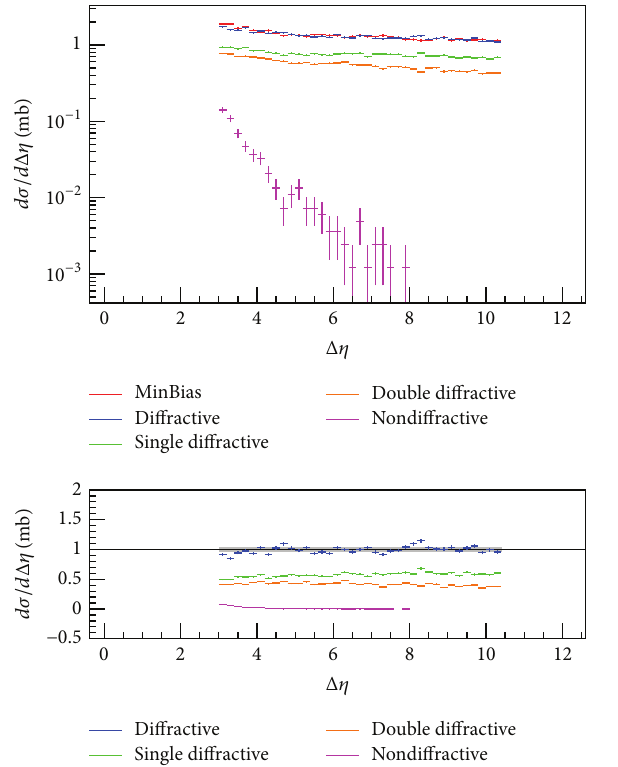
Figure 9: Large rapidity gap distribution for the events that have a central gap Δ𝜂 > 4 with a cut of 𝑝 T > 200 MeV for all final state particles in |𝜂| < 5.2 . The MinBias event class is used as a reference for the